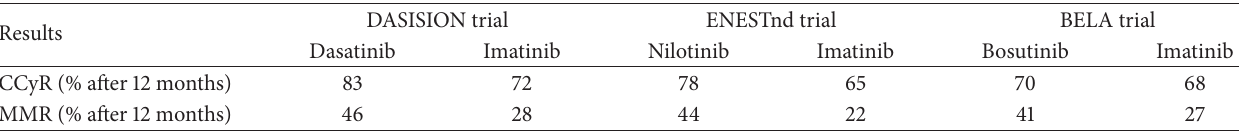
Table 2: Summary of the 12-month results of ENESTnd, DASISION, and BELA clinical trials that have recently demonstrated the superiority of second-generation TKI in terms of complete cytogenetic response (CCyR) and major molecular response (MMR) versus imatinib in first- line treatment of CML